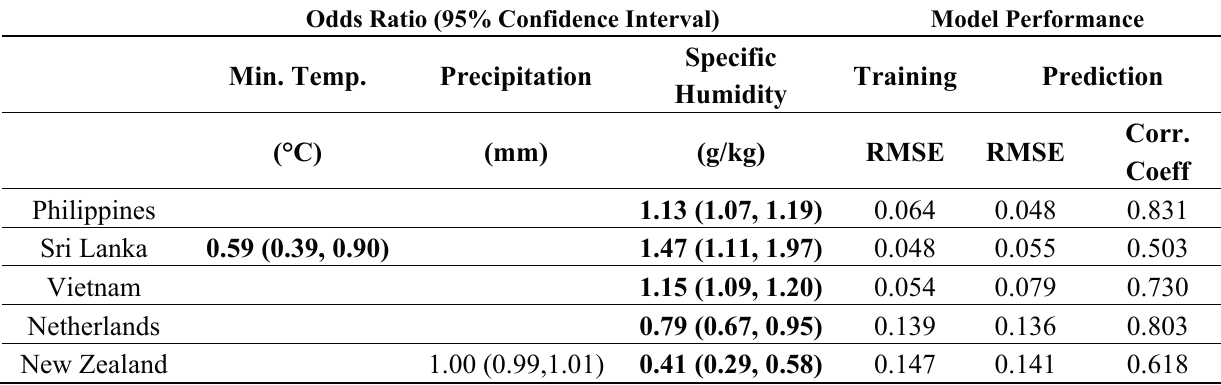
Table 1. Multivariate regression between influenza positive proportion and meteorological parameters. Bold font indicates significance at α = 0.05 levels, RMSE indicate root mean squared error and Corr. Coeff. is the correlation coefficient between the observed and predicted influenza positive proportion. The models were adjusted for previous weeks’ influenza activity, seasonality and other possible nonlinear relationships (modeled as a polynomial function, up to degree of 3, of the week number). When OR is not shown, the variable is not selected by the backward selection (not included in the final